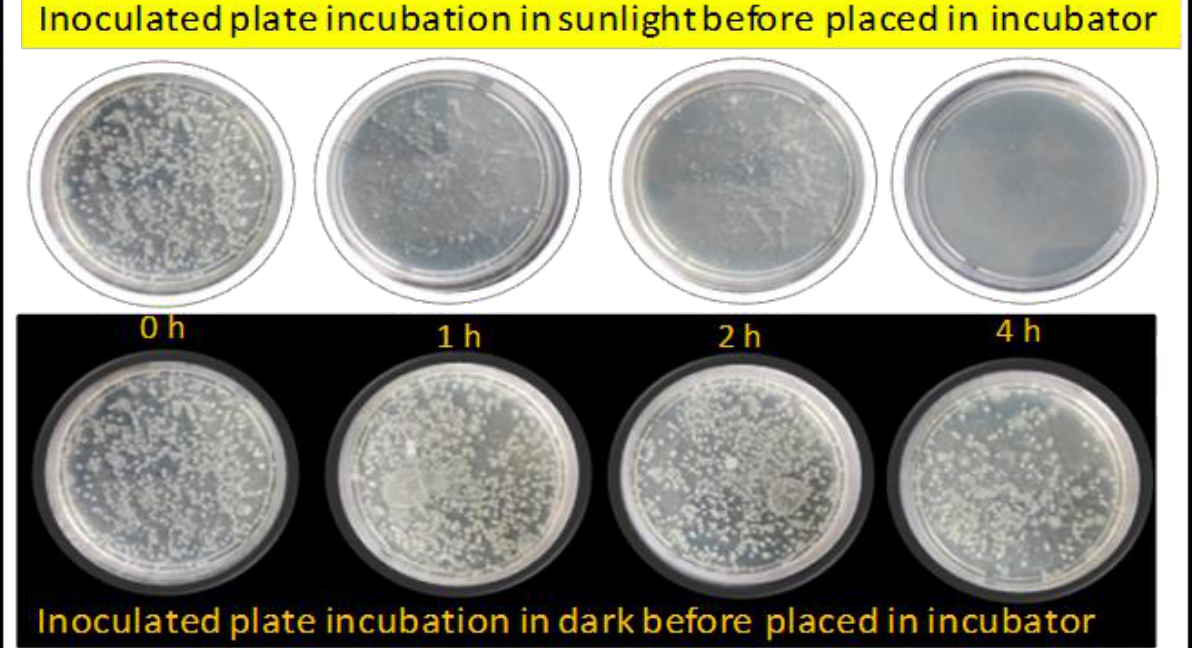
Figure 13. Bacterial growth control properties of Ni 3 S 4 /Ag 2 S/TiO 2 /CA aerogel at different time intervals of 0 – 4 h in the absence and presence of sunlight (aerogel dose 100 µ g/mL).